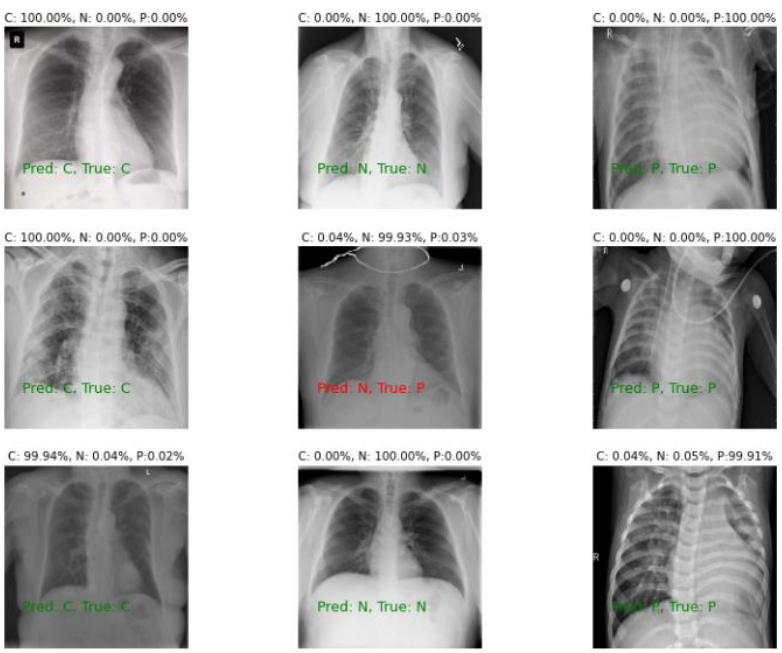
Figure 9. Three classification results of some sample images of the test set in dataset D1 (three random images for each category, nine images in total), the true label in the leftmost column is COVID, and the true label in the middle column is normal, the ground truth label for the rightmost column is pneumonia.